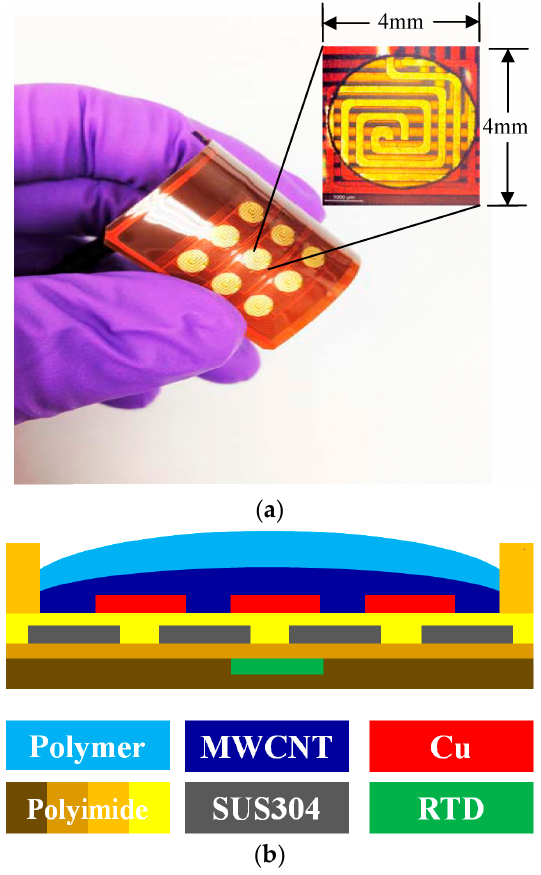
Figure 2. ( a ) configuration of the flexible gas sensor array. The inset shows the sensing electrode ( top electrode) and the heater ( bottom electrode); and ( b ) the cross-sectional schematic structure of the single gas sensor.